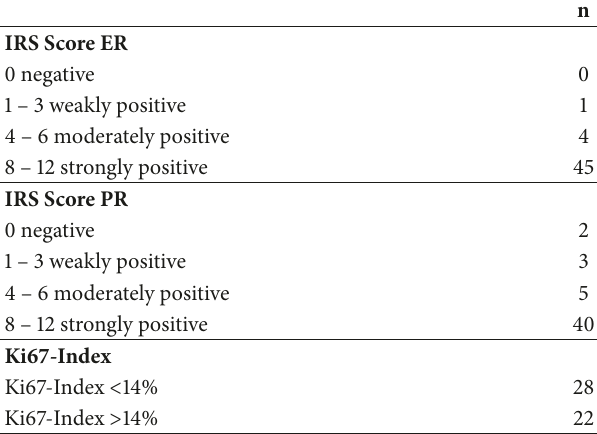
Table2:Immunoreactivescore(IRS)ofoestrogenandprogesterone receptor (ER and PR) and index of Ki67